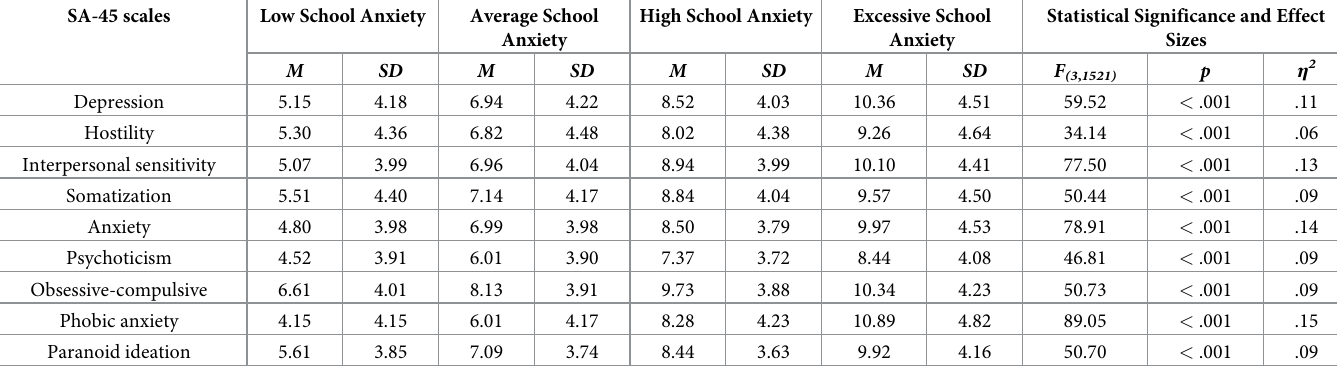
Paranoid ideation Note : SA-45 = Symptom Assessment-45 Questionnaire.